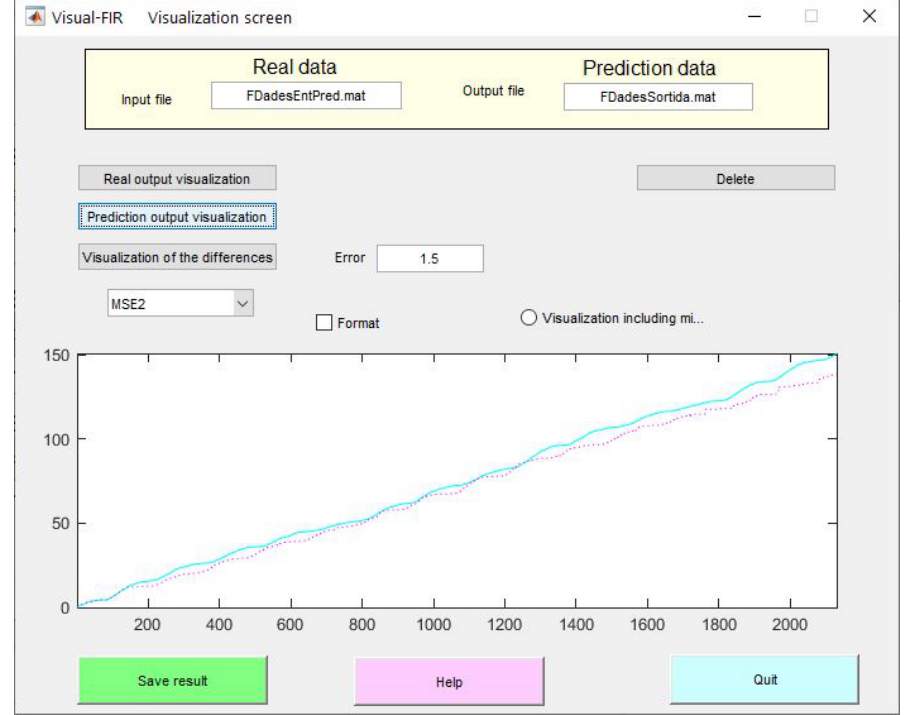
Figure 7. Accumulated consumption in three different periods of time corresponding with refilling periods.